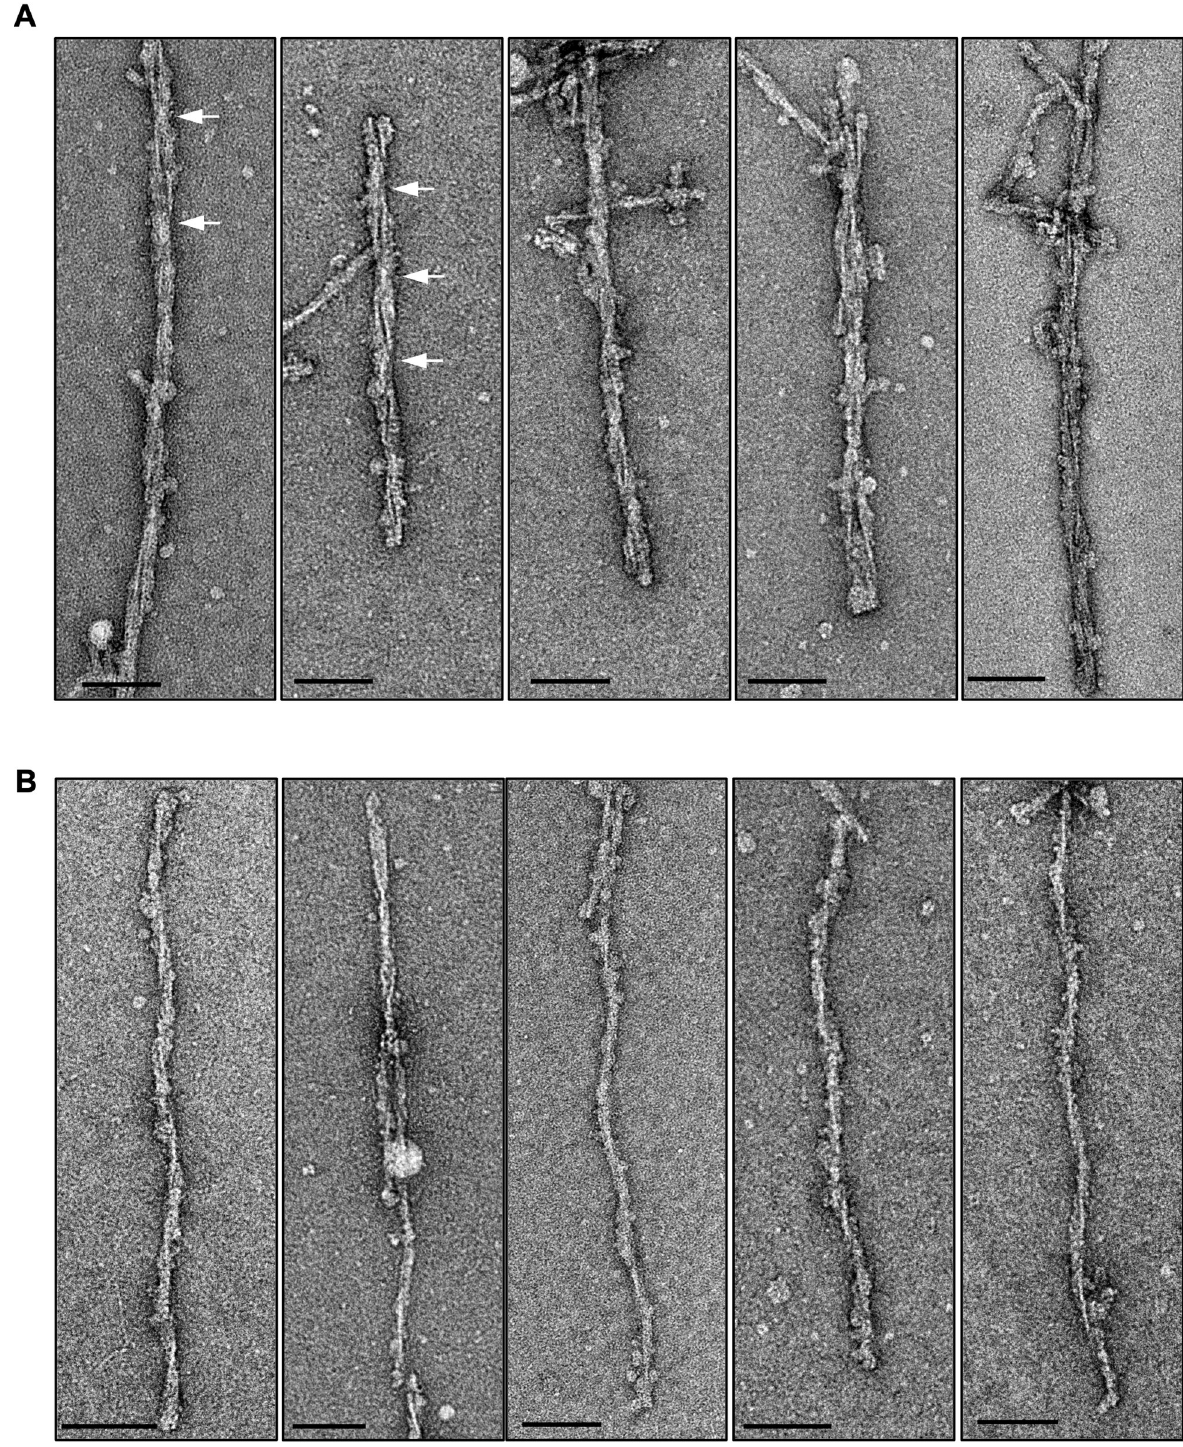
Fig 3. Gallery of negatively stained L-type BSE fibrils. Representative electron micrographs of L-type BSE fibrils with distinct morphologies containing two- ( A ) and one-protofilament ( B ) fibrils. The crossover regions for selected two-protofilament fibrils are shown using white arrows. Grids stained with 2% uranyl acetate. Scale bar = 100